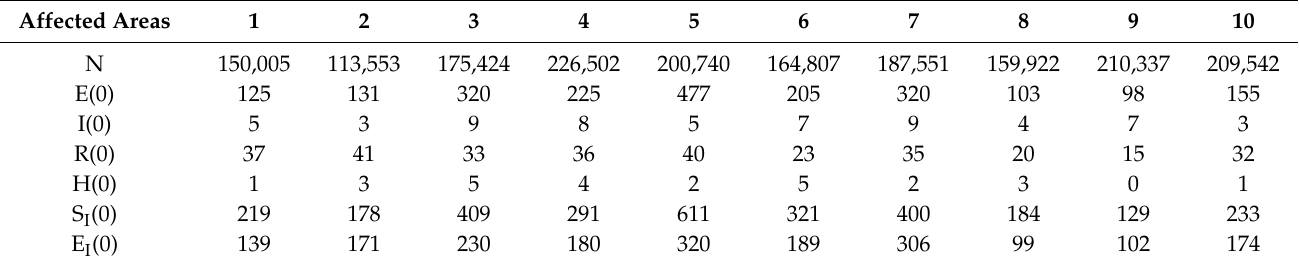
Table 2. Initial values of affected areas.